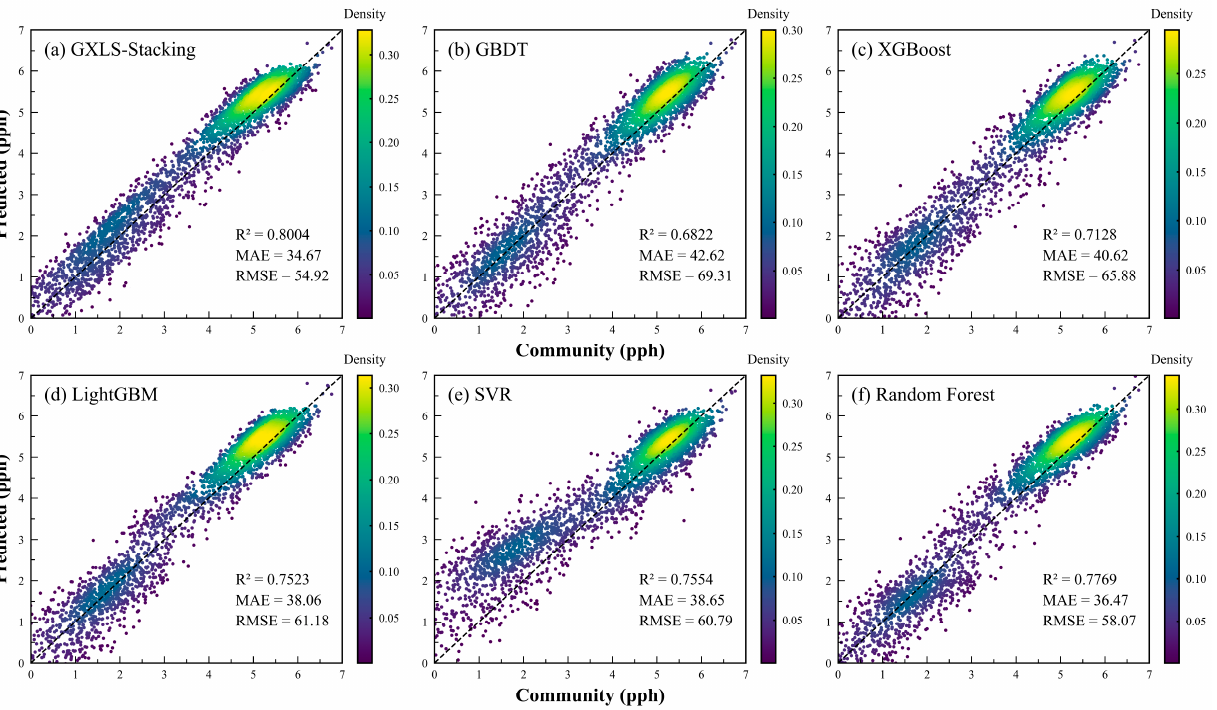
Figure 7. Scatter plots of the predicted by optimal models and the community committee sites population density at the pixel level (Total of 3485 pixels). A ln-ln transformation was conducted for the population density. The black dash line indicate 1:1 line. pph: persons per